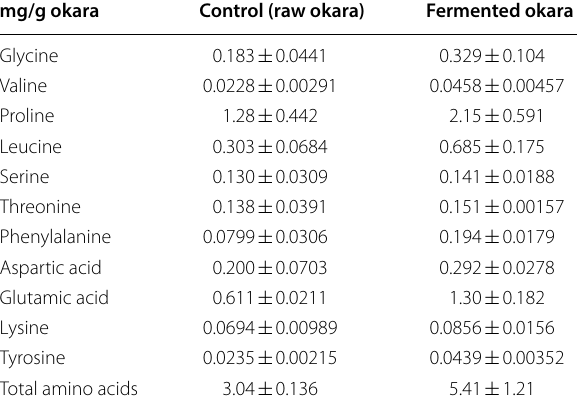
Results are as mean